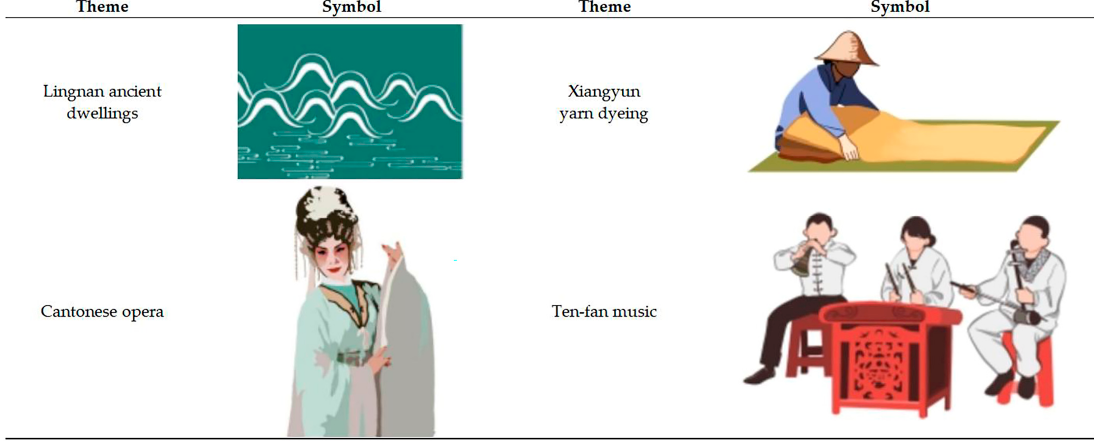
Figure 7. Graphic symbol